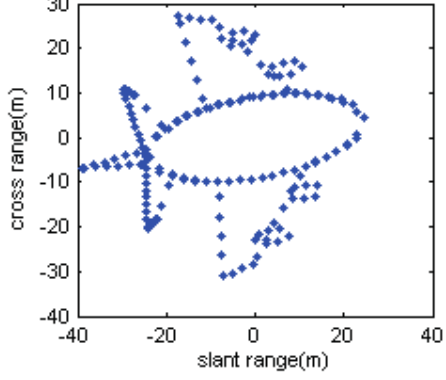
Figure 5. Simulated target